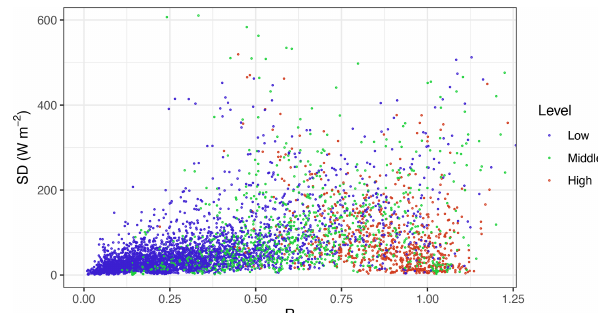
Figure 3. SD– R plot of the whole dataset concerning the cloud base altitude grouped into three levels, namely low-level clouds ( < 2km), mid-altitude clouds (2–7km) and high-altitude clouds ( >